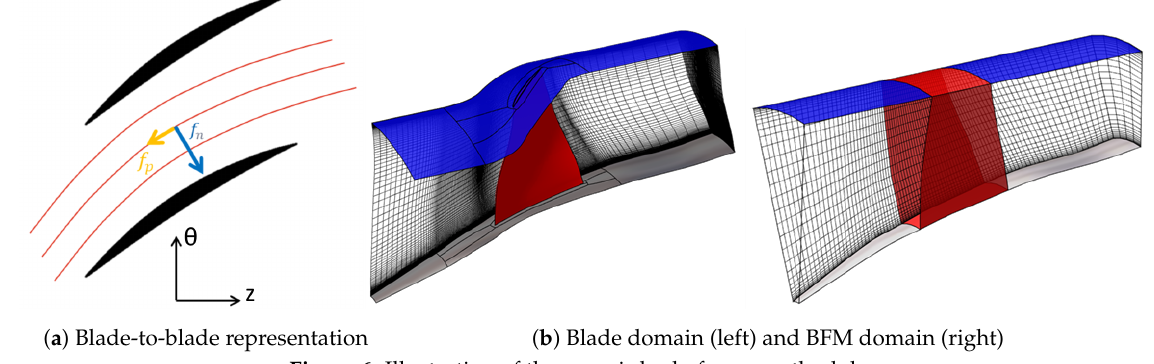
Figure 6. Illustration of the generic body forces